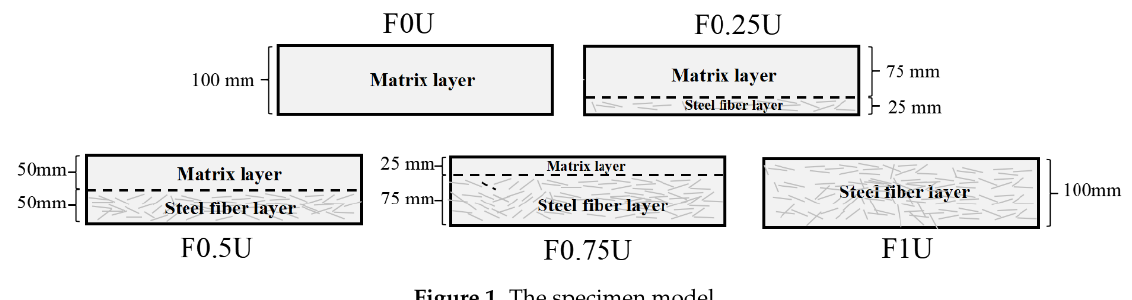
Figure 1. The specimen model.